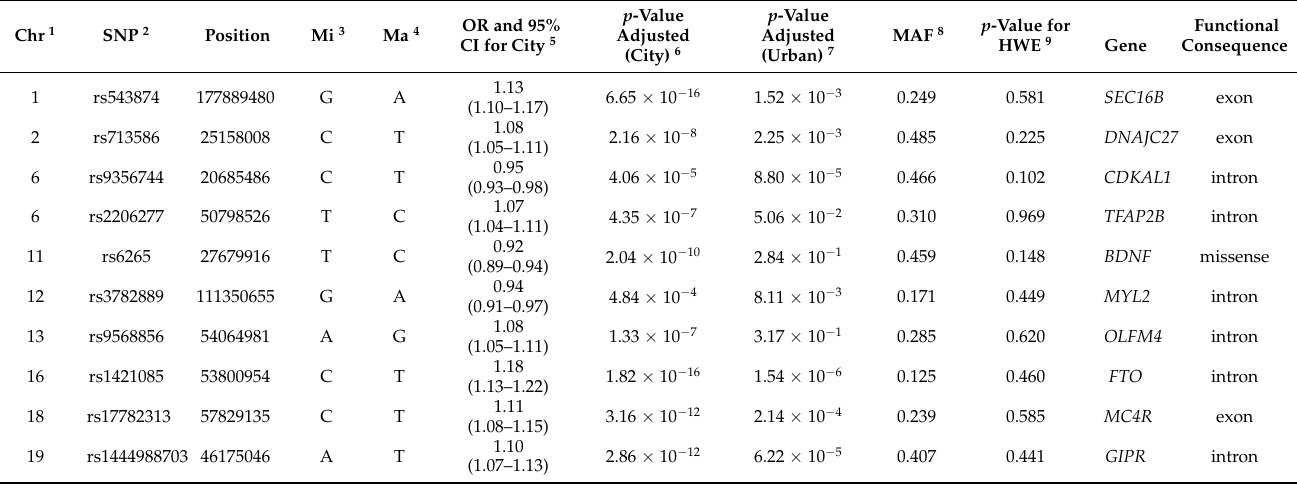
1 Chromosome; 2 single nucleotide polymorphism; 3 minor allele; 4 major allele, 5 odds ratio (OR) and 95% confidence intervals (CI) for city cohort; 6 p -value for OR after adjusting for age, gender, residence area, survey year, body mass index, daily energy intake, education, income and regular exercise in the city cohort; 7 p -value for OR for Ansan/Ansung cohort after adjusting the covariates; 8 minor allele frequency; 9 Hardy − Weinberg